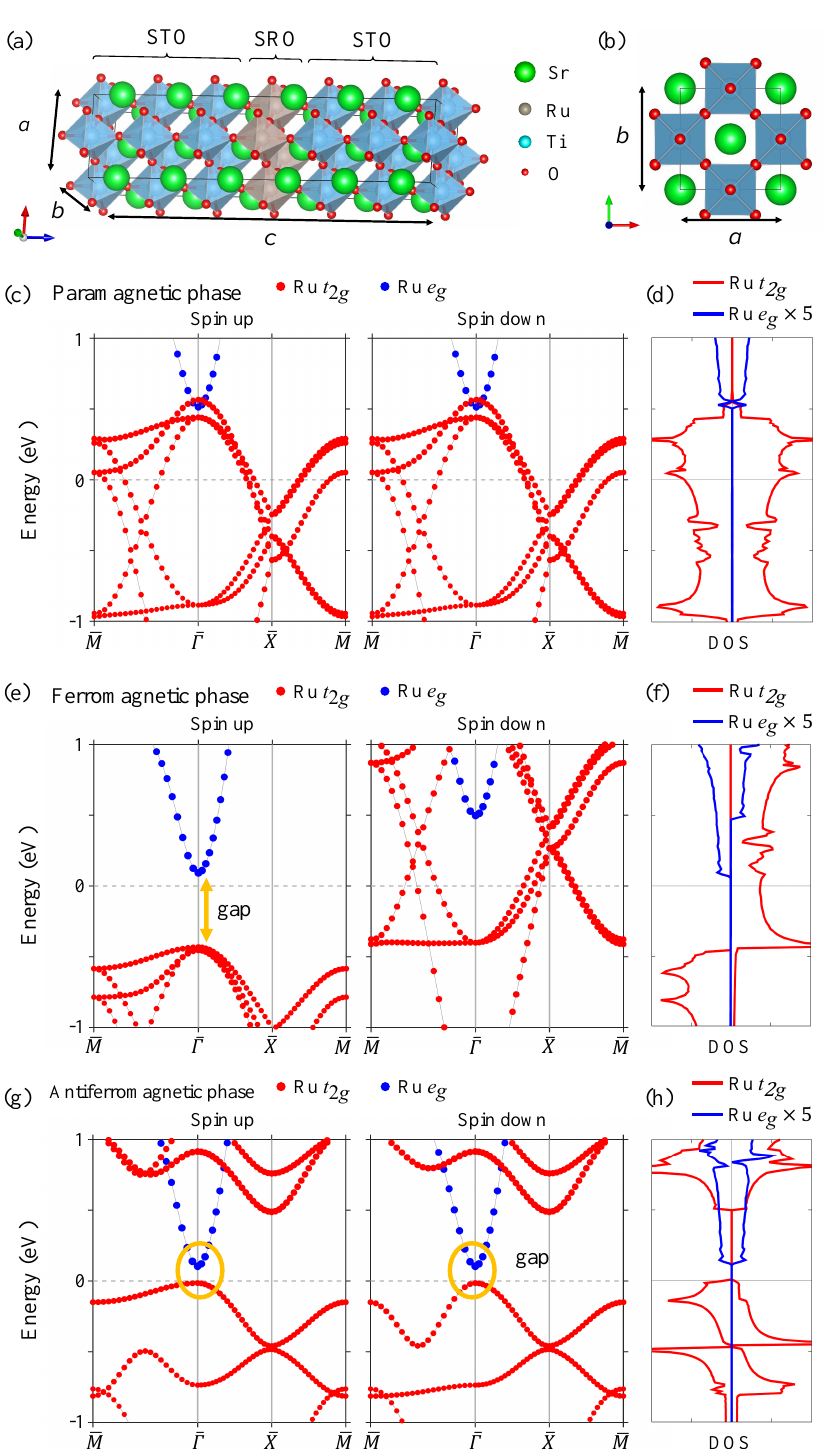
Figure 2. Side ( a ) and top ( b ) view of the ( SRO ) 1 / ( STO ) 5 superlattice structure used in the calculations. ( c , e , g ) Band structures of three magnetic phases of ( SRO ) 1 / ( STO ) 5 superlattice. The red (blue) dots present the component of Ru t 2 g and e g orbitals. The orange circle and arrow highlight the band gap. ( d , f , h ) The total density of states of each magnetic